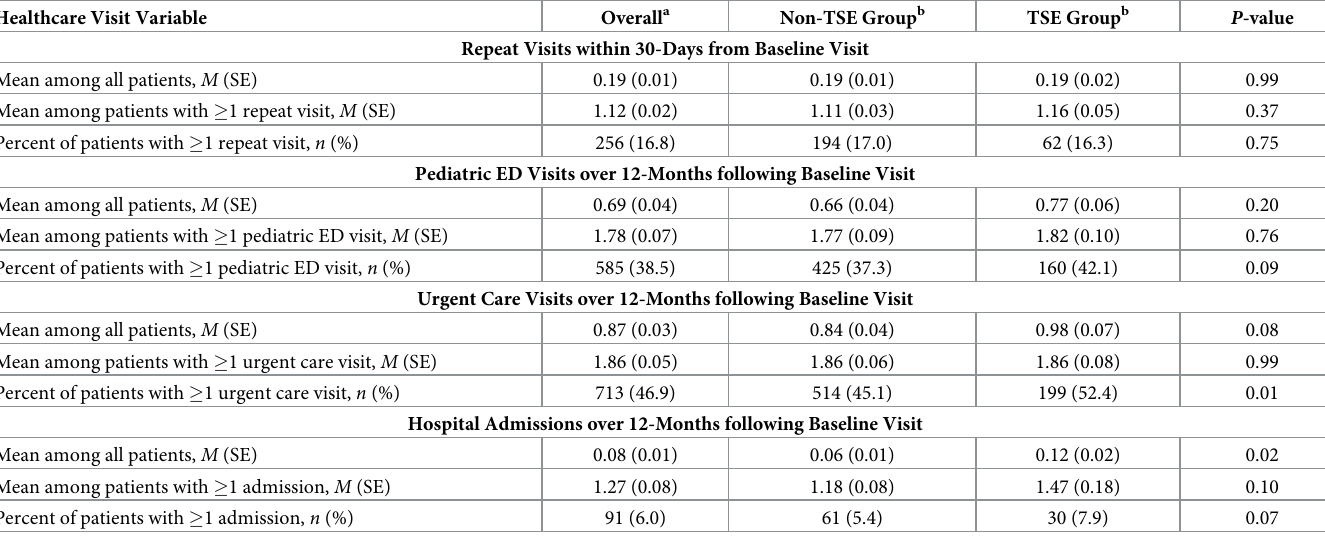
Table 2. Healthcare visit and hospitalization patterns over 12-months by tobacco smoke exposure group status among nonsmoking children ages 0–17 years. Healthcare Visit